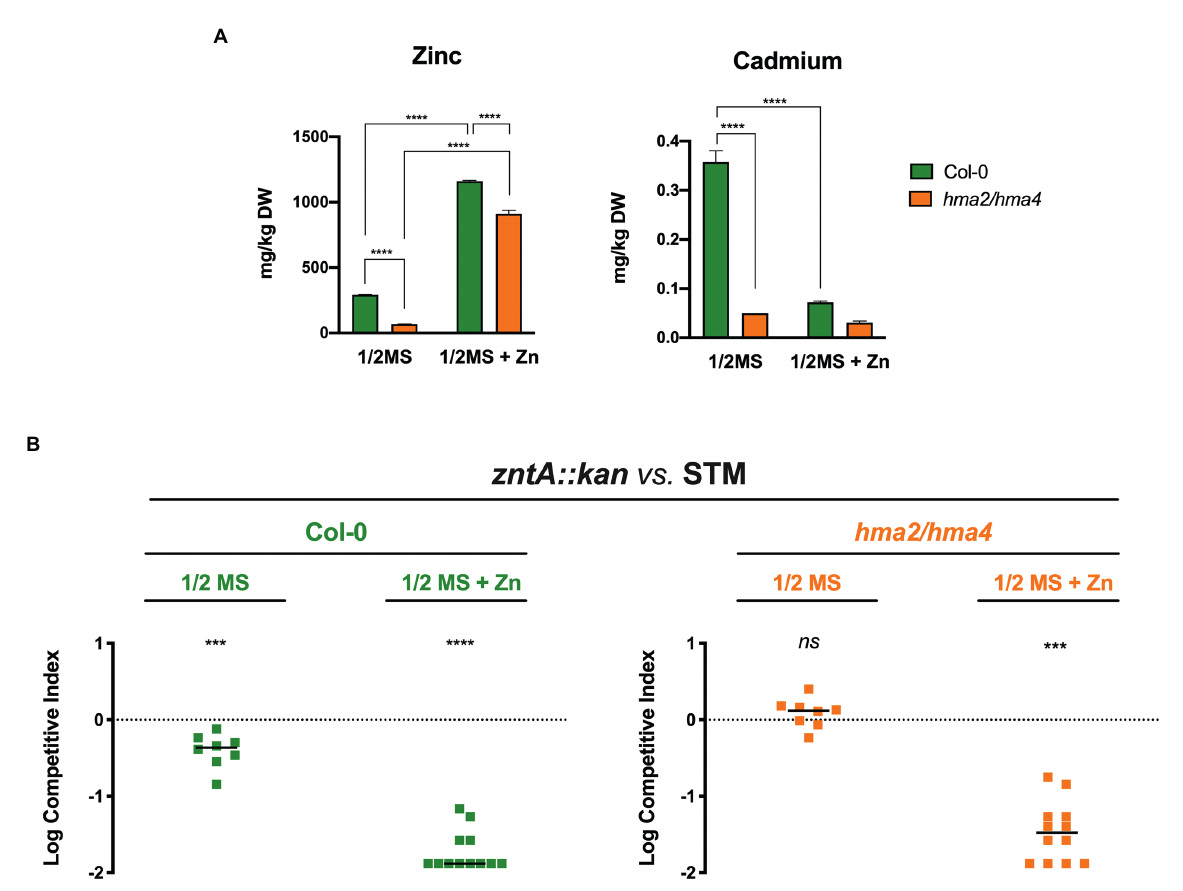
FIGURE 4 Salmonella colonization of Arabidopsis thaliana related to Zn and Cd shoots content. (A) Inductively coupled plasma mass spectrometer (ICP-MS) analyses of Col-0 and hma2/hma4 shoots, grown in 1/2MS or 1/2MS + Zn. Statistical differences were calculated by Two-way ANOVA and Sidak’s multiple comparison test (**** p < 0.0001). (B) Competition assays in Col-0 and hma2/hma4 between zntA::kan (strain A) and STM (strain B). Competitive indexes were calculated as described in section “Materials and methods,” and the statistical significance was determined by the Student’s t -test (*** p < 0.005; **** p < 0.0001; and ns, not significant). The diagram shows a representative experiment of two independent